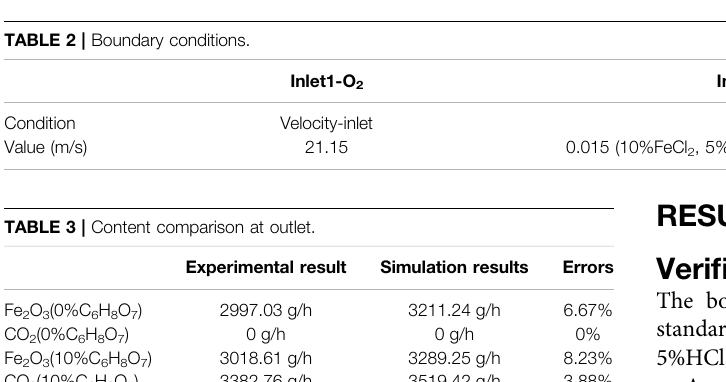
TABLE 2 | Boundary conditions.